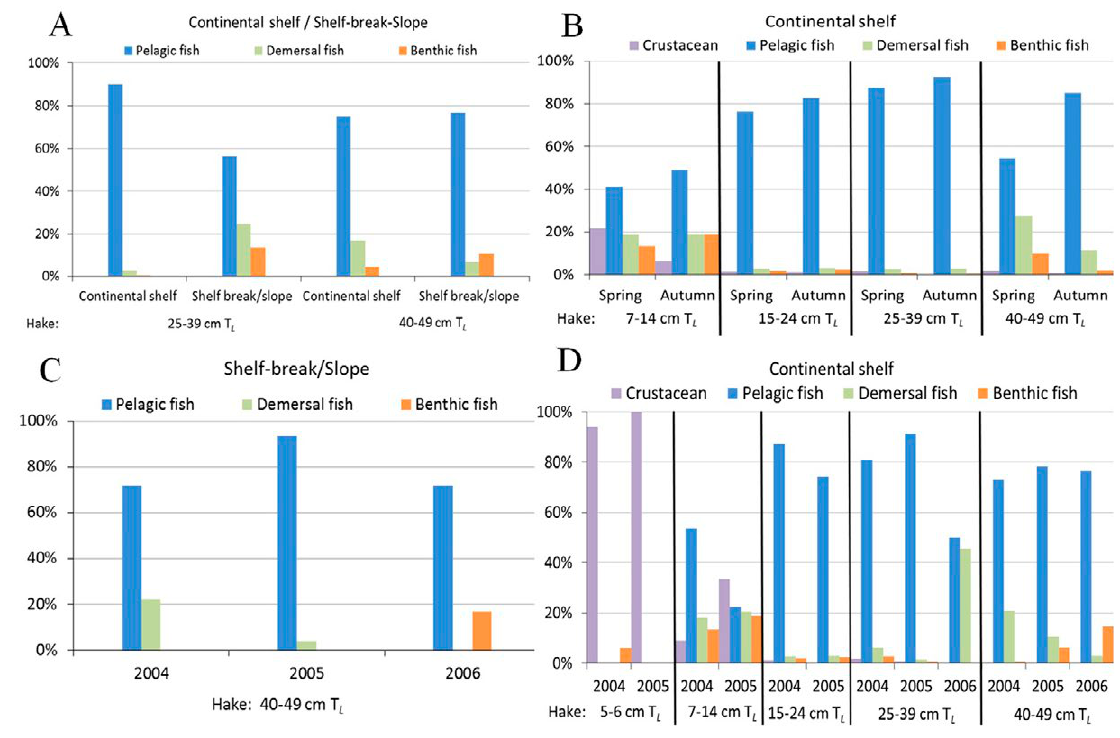
Fig. 4. – Spatio-temporal feeding variations of main prey groups according to (A) depth, (B) season, (C-D)